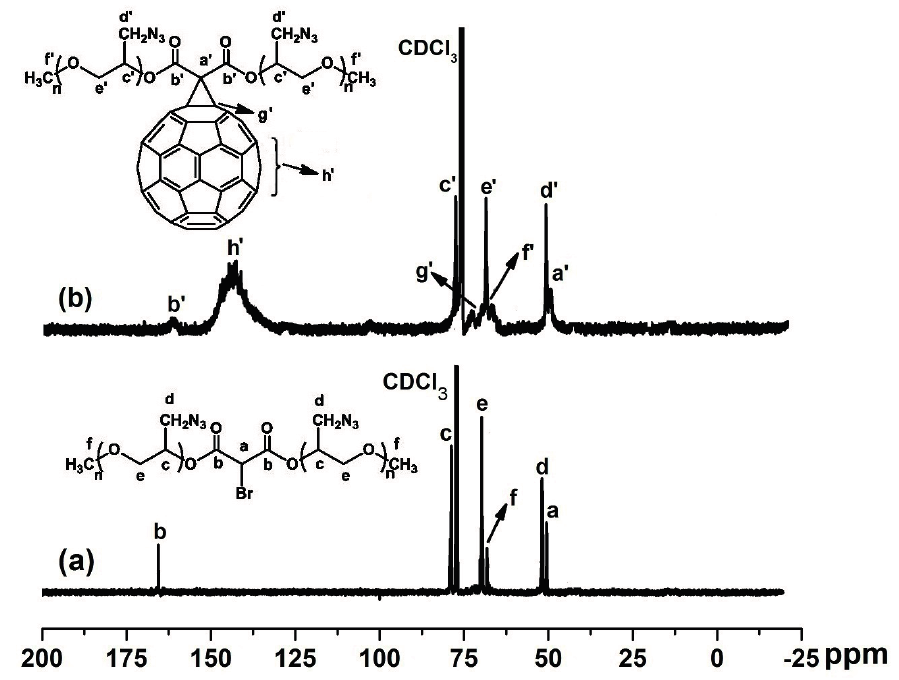
Figure 4. 13 C NMR spectra of ( a ) BM-GAP and ( b ) C 60